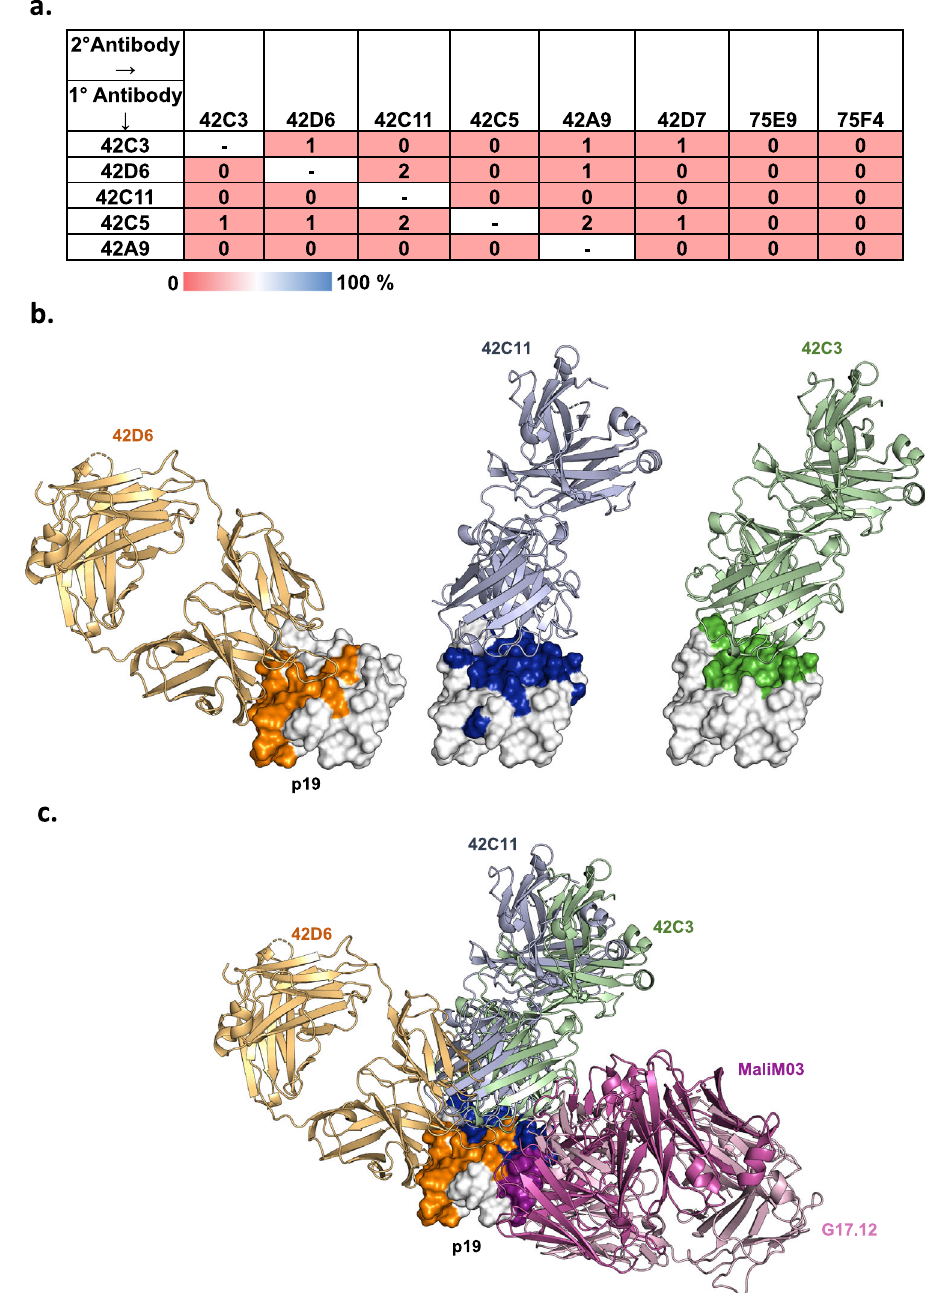
Fig. 2 | 42D6 is a potent strain-transcending neutralizing Ab targeting a dis- tinctepitopethatpartiallyoverlapswithsitesboundbynon-neutralizingAbs. a Epitopebinning for the p19-speci fi c human mAbs. Primarysaturating antibodies tested are listed in the left column, while secondary competing antibodies are listedatthe top in rows. Data indicate the percent of competing antibody binding compared to the maximum competing antibody response in the absence of the primary antibody. Boxes are colored according to competition status. Antibodies that displayed ≤ 50% maximal binding are colored light red and are considered “ competing ” . Negative values were normalized to 0. b Crystal structures of p19 bound to the Fab fragment of 42D6 (bright orange), 42C11 (light blue), and 42C3